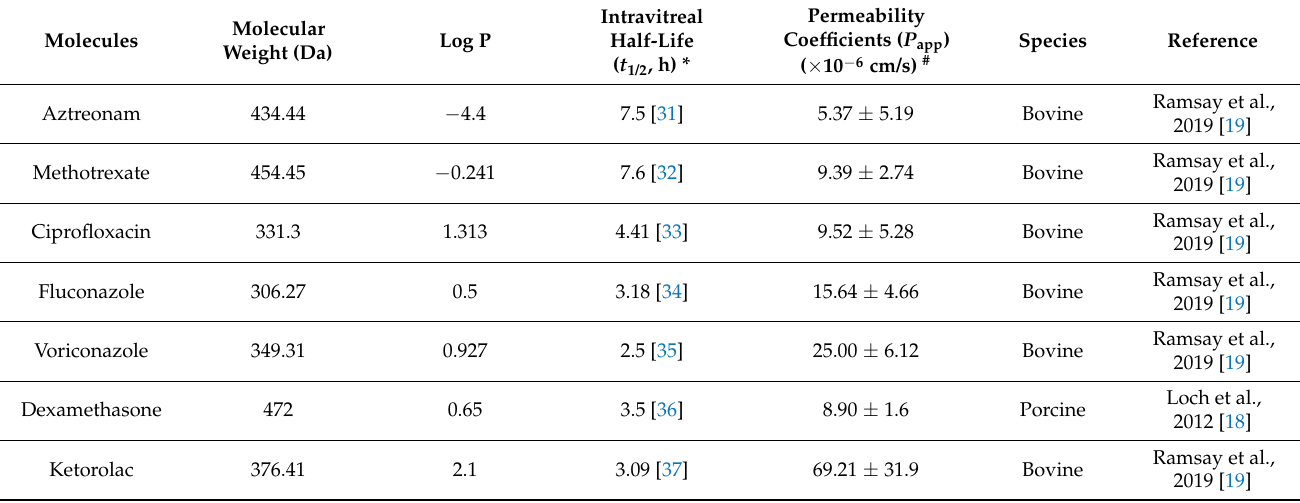
Table 3. Physicochemical properties, intravitreal half-lives, and permeability coefficients of ophthalmic drug molecules in previous